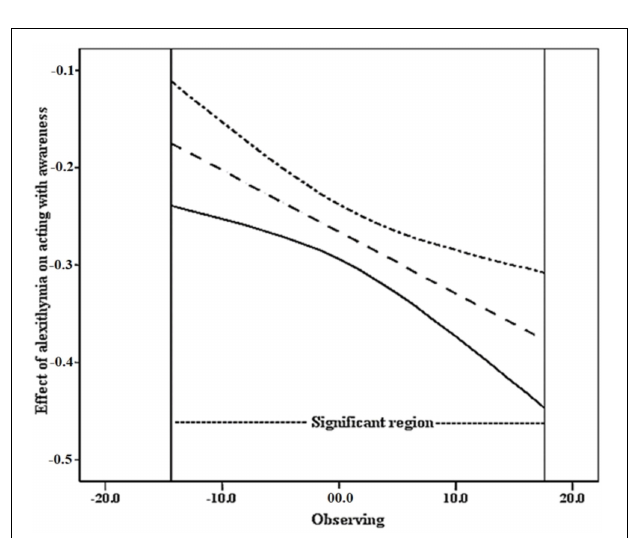
FIGURE 3 | The conditional effect between alexithymia and acting with awareness ( N = 901). To further understand the moderation effect of observing on the path between alexithymia and acting with awareness, a conditional indirect effect analysis was conducted at 16 th , 50 th , and 84 th percentiles of the observing facet.